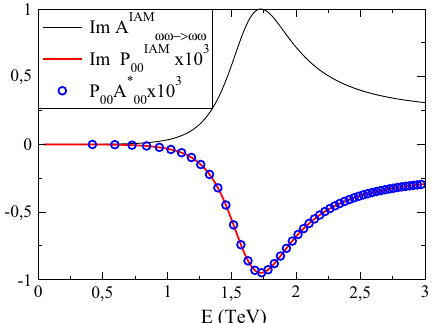
Fig. 4 Example of the broad resonance generated by elastic ωω scat- tering, which illustrates the unitarity of P 00 in the absence of coupling to the hh channel. The parameters employed are a = 0 . 81, b = a 2 , a 4 (μ = 3 TeV ) = 4 × 10 − 4 . (All other NLO parameters vanish at that scale)